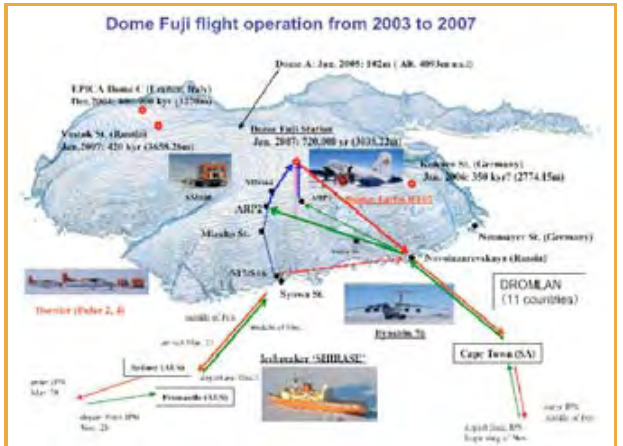
Figure 1. Dome Fuji station and other deep ice coring sites on Antarc- tica ice sheet. The routes to and from Dome Fuji station are shown by the green, red, and blue arrows.